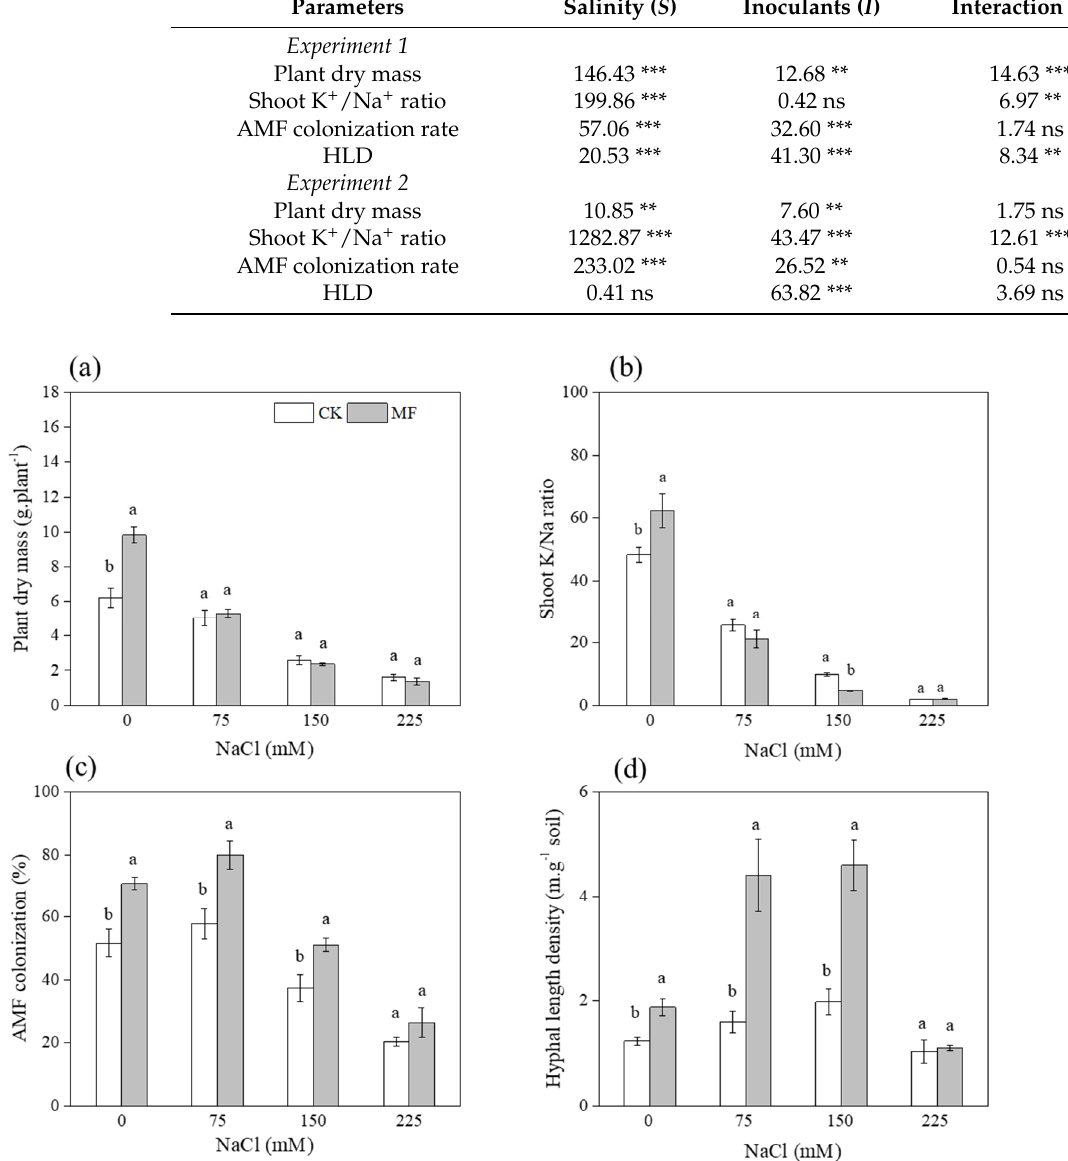
Figure 1. Effects of salinity levels (0, 75, 150, and 225 mM NaCl conditions) and inoculum types (CK and MF inoculated treatment) on plant dry mass ( a ), shoot K + /Na + ratio ( b ), AM fungal colonization rate in root ( c ), and hyphal length density in soil ( d ), respectively. Values are mean ± SE ( n = 3). Different lowercase letters indicate significant differences between CK and MF. Inoculated treatments were tested using a t ‐ test at 95% confidence level.